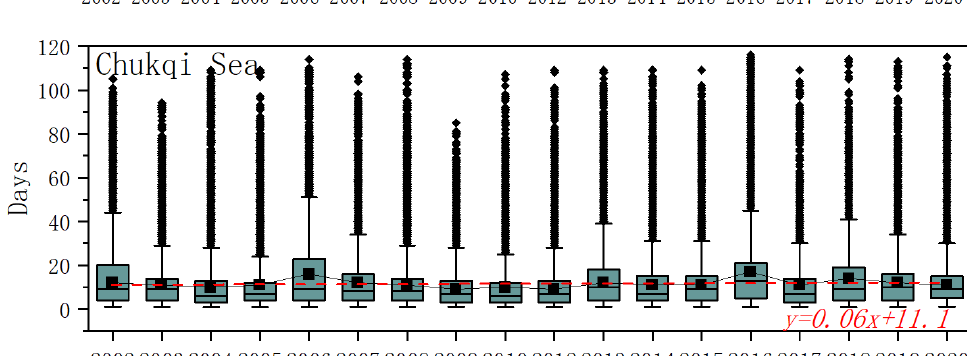
Figure 15. Number of days from freezing up to complete freezing of sea ice in Kara Sea, Laptev Sea, East Siberian Sea, and Chukchi Sea from 2002 to 2020. The standard errors were 0.07, 0.09, 0.15, and 0.09, respectively, and passed the significance test ( p < 0.05).